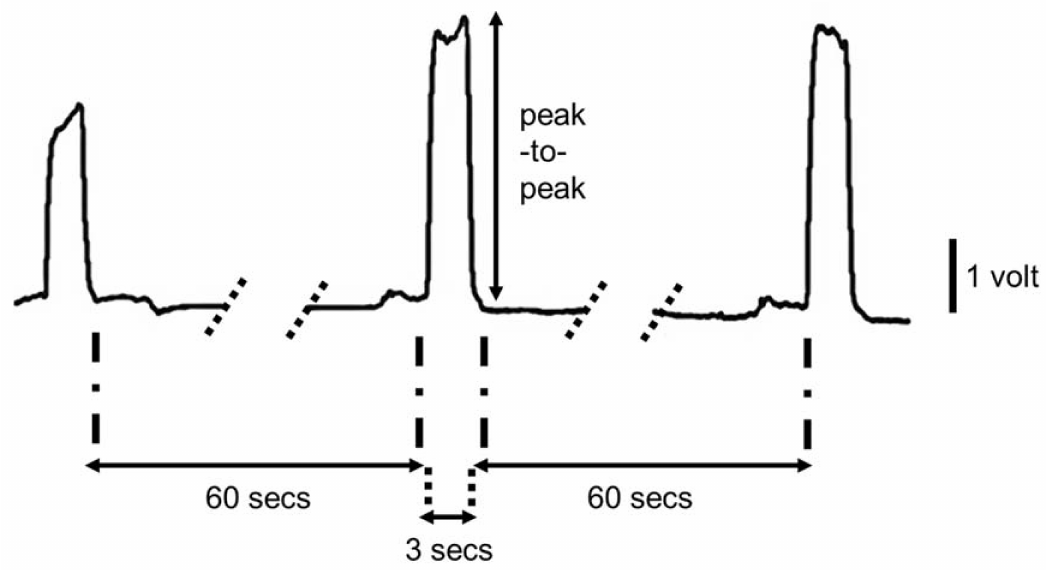
Figure 2. A sample recording is shown from a subject is shown. Each peak belongs to a maximal bite trial that lasts about 3 s, with about 60 s interval between each